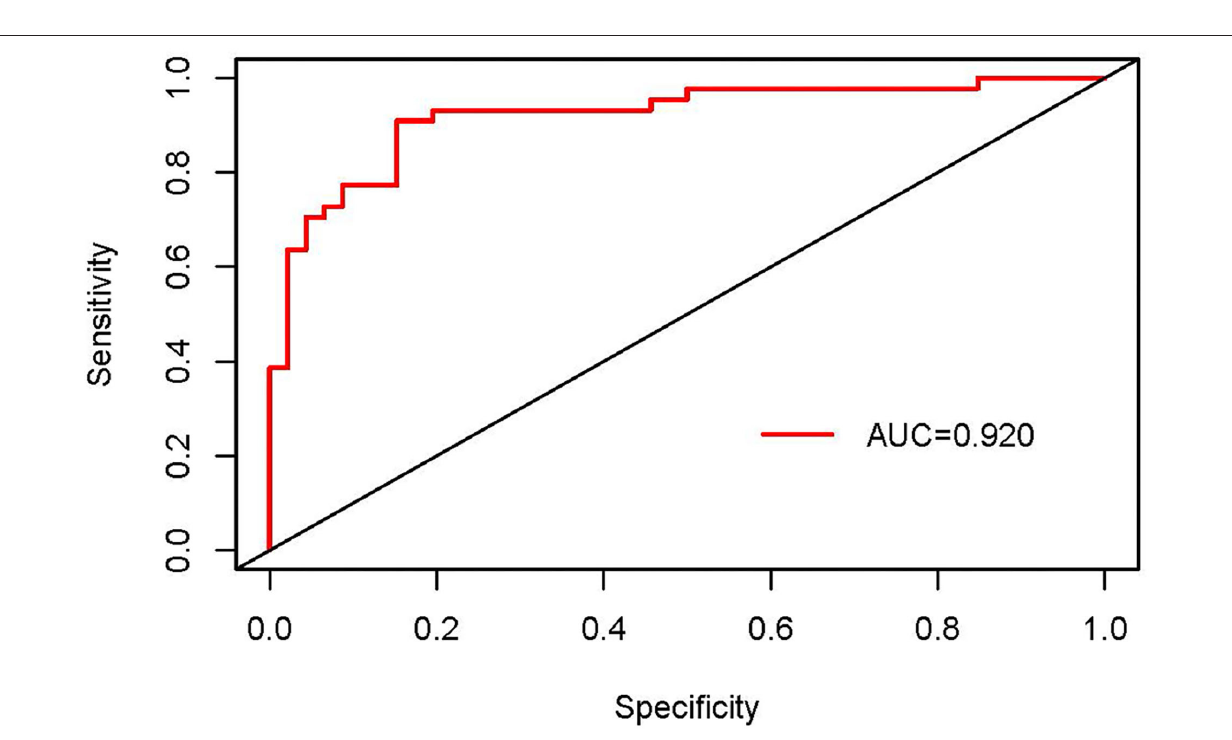
Frontiers in Psychiatry |